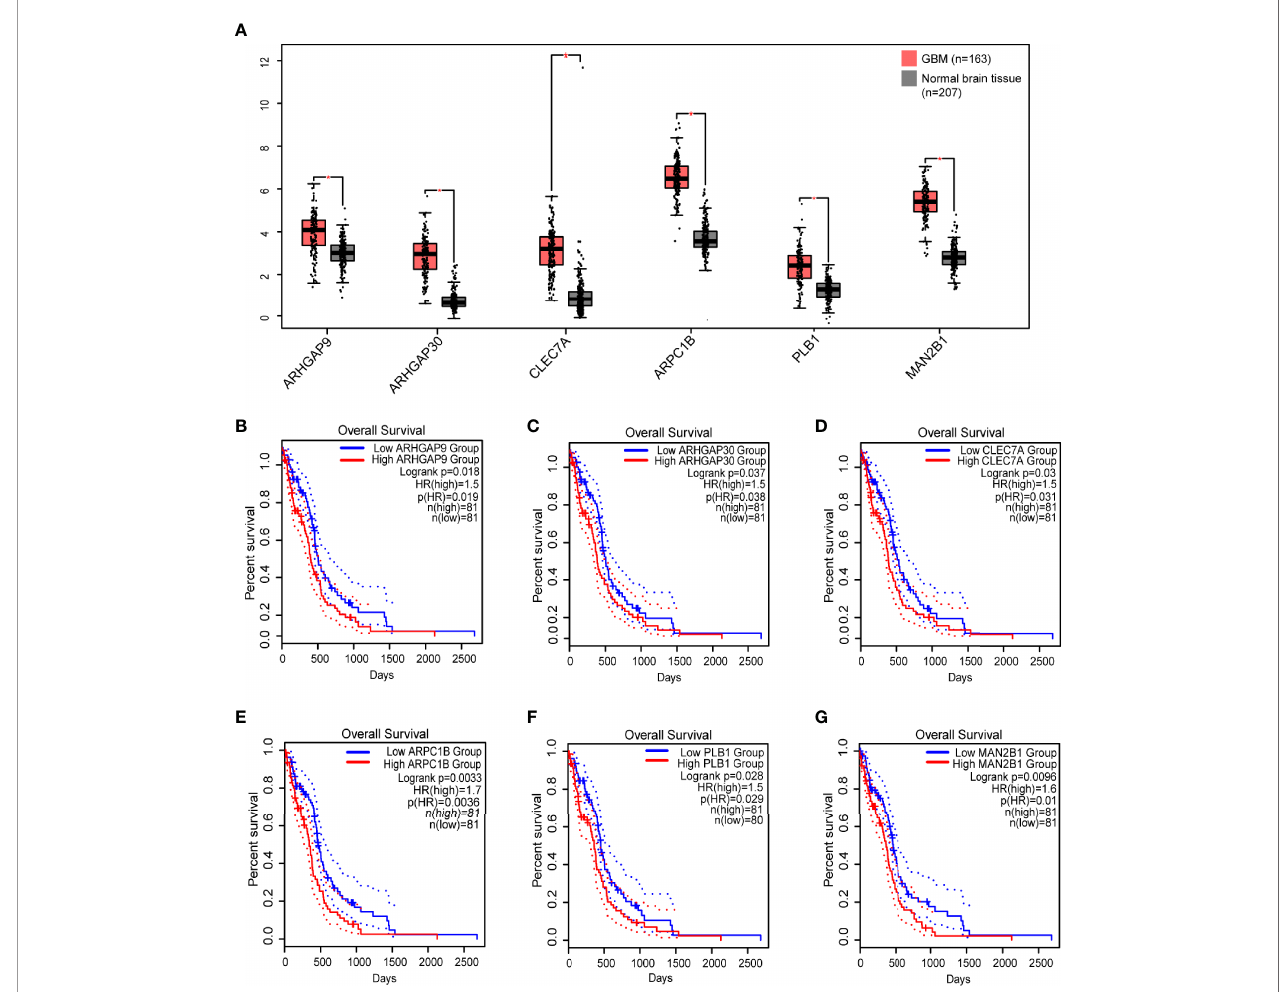
FIGURE 2 | Identi fi cation of tumor antigens associated with GBM prognosis. (A) Differential expression of six candidates in normal brain tissue and GBMs. *, signi fi cant difference. Kaplan-Meier curves showing OS of GBM patients strati fi ed on the basis of (B) ARHGAP9, (C) ARHGAP30, (D) CLEC7A, (E) ARPC1B, (F) PLB1 and (G) MAN2B1 expression levels. 50% (Median) cutoff was set up for dividing low and high expression groups. Log-rank test was used for hypothesis testing, and a p -value <0.05 was considered statistically signi fi